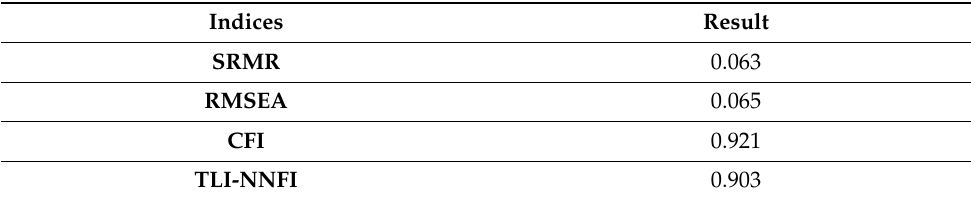
Table 5. Results of CFA. Source: composed by the authors, using IBM SPSS Statistics 26 (Armonk, NY: IBM